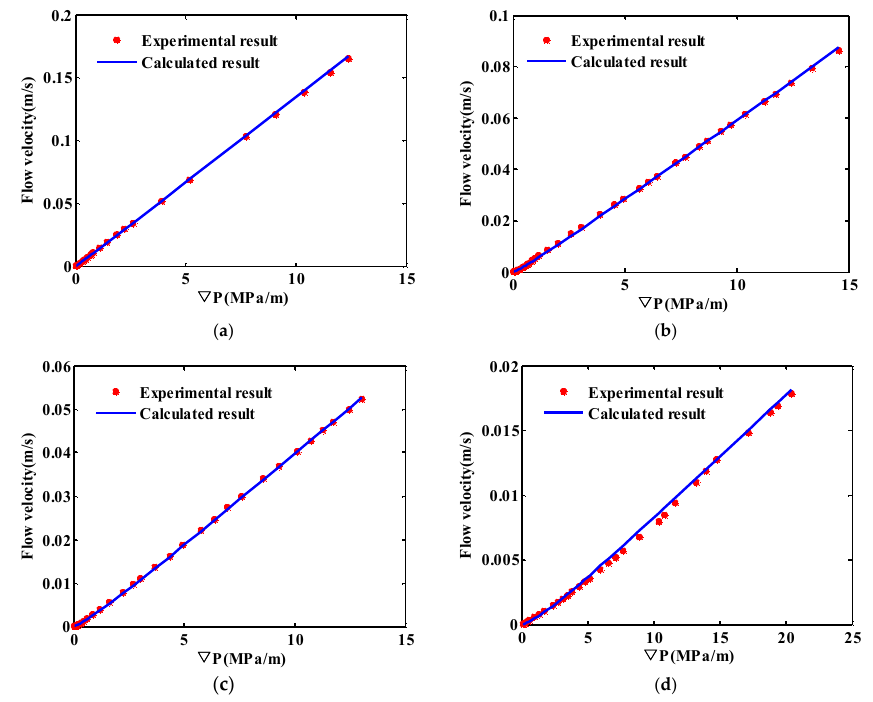
Figure 7. Comparison of predictive velocity versus ∇ P and Li’s experimental results [31]: ( a ) R = 10.03 μ m; ( b ) R = 6.79 μ m; ( c ) R = 5.62 μ m; ( d ) R = 2.62 μ m.